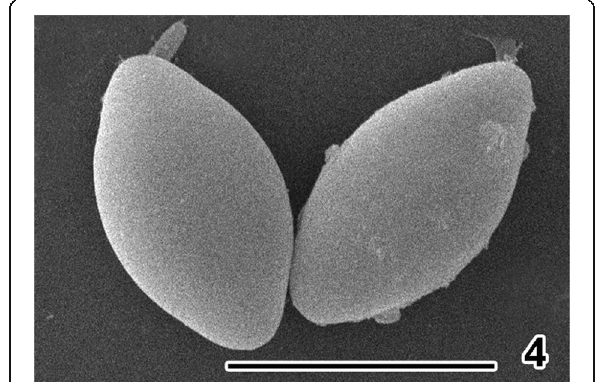
Fig. 4 Oocysts of Mattesia dispora , SEM. Note the navicular oocysts. Bars, 10 μ m